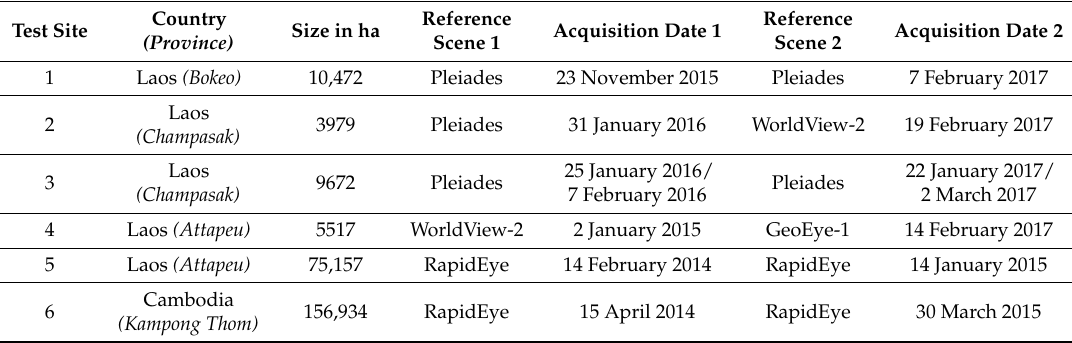
Table 1. Test sites and VHR/HR imagery (type, acquisition date) used for